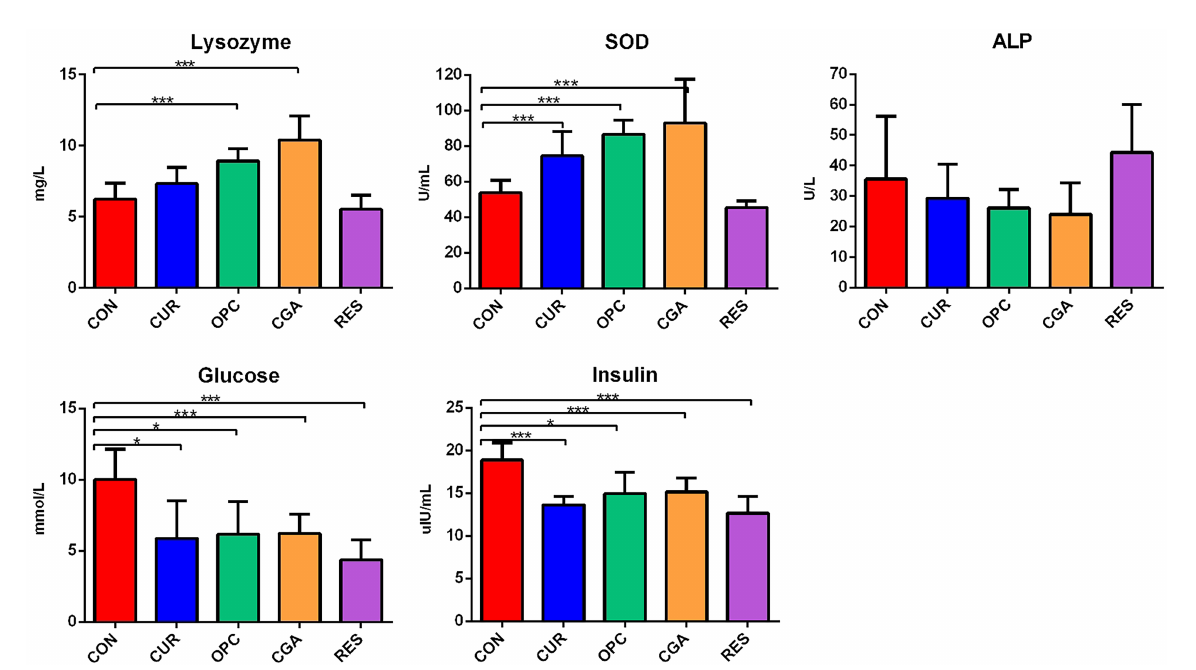
FIGURE 1 Effect of plant polyphenols on blood parameters of fish ( n = 9 per treatment). Data are presented as mean ± standard deviation. Significant differences were labeled as * and *** for p < 0.05 and p < 0.001, respectively. SOD, Superoxide dismutase, ALP, alkaline phosphatase, CON, control group; CUR, curcumin group; OPC, oligomeric proantho cyanidins group; CGA, chlorogenic acid group; RES, resveratrol